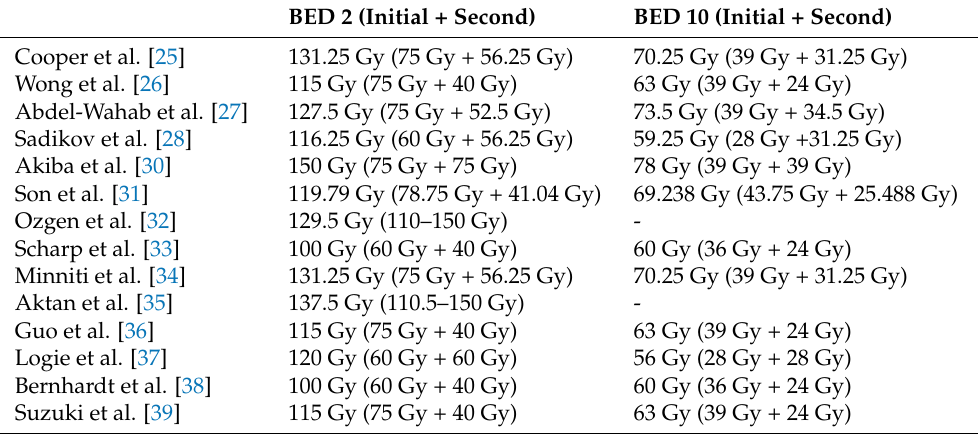
Table 5. Cumulative biological effective dose of previous